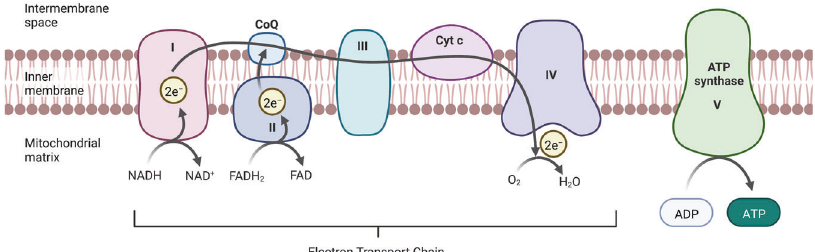
Fig. 3 The oxidative phosphorylation complexes in the electron transport chain (ETC) of mitochondrion. Complex I (Co-I) receives electrons from NADH. Complex II (Co-II) represents a point of intersection between tricarboxylic acid cycle and electron transport. Mobile electron carriers, like coenzyme Q (CoQ) and cytochrome c, move electrons between protein complexes. Complex III (Co-III) is the CoQ- cytochrome c oxidoreductase. Complex IV (Co-IV) is also known as cytochrome c oxidase (COX). This complex terminates the fl ow of electrons through the ETC, reducing oxygen to water. Finally, complex V (Co-V) generates ATP from the energy stored by the proton gradient established through the previous step by step